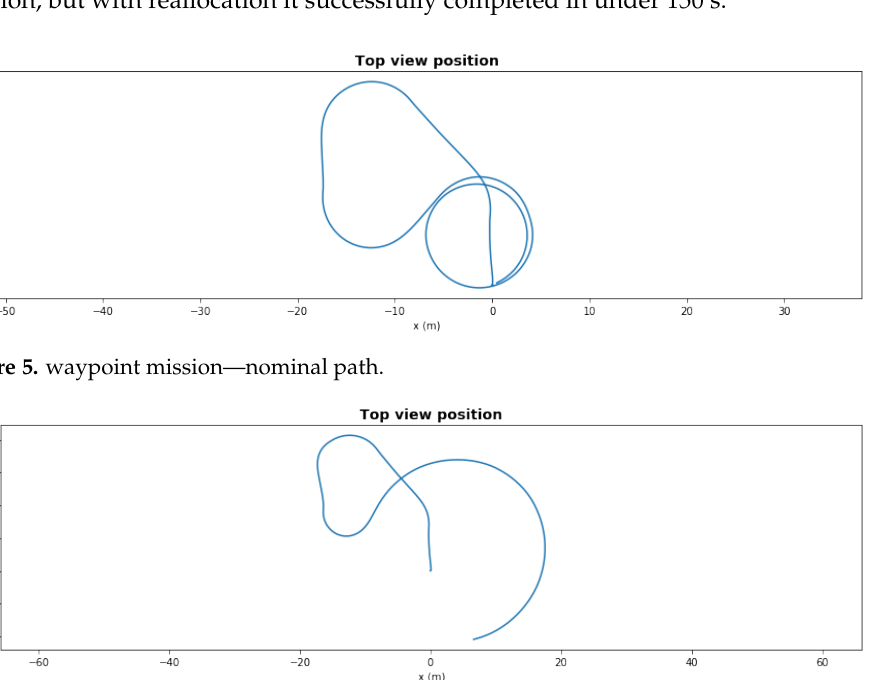
Figure 6. waypoint mission—path with severe